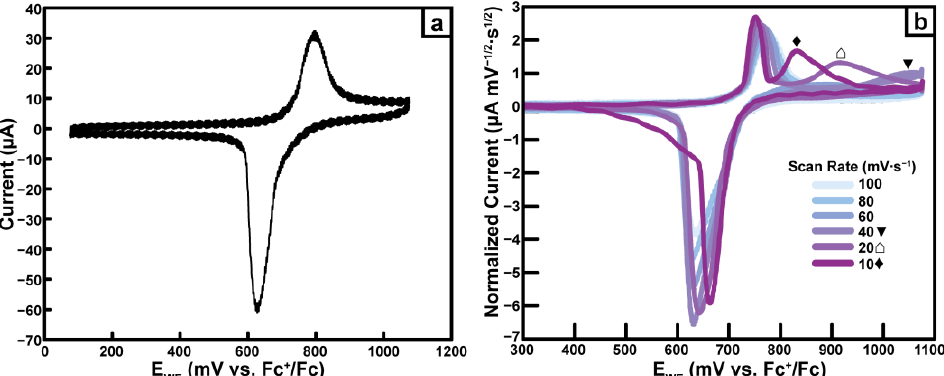
Figure 4. Cyclic voltammograms of Pd(dppf)TPT (0.30 mM) in DCM (100 mM TBAPF 6 ) acquired within a fixed potential window; shown are the second cycles of each respective scan rate acquisition: ( a ). CV at a scan rate = 250 mV ∙ s −1 . ( b ). CVs at varying scan rates (10 – 100 mV ∙ s −1 ); current is normalized to the scan rate ( ν ) by dividing by ν 1/2 .